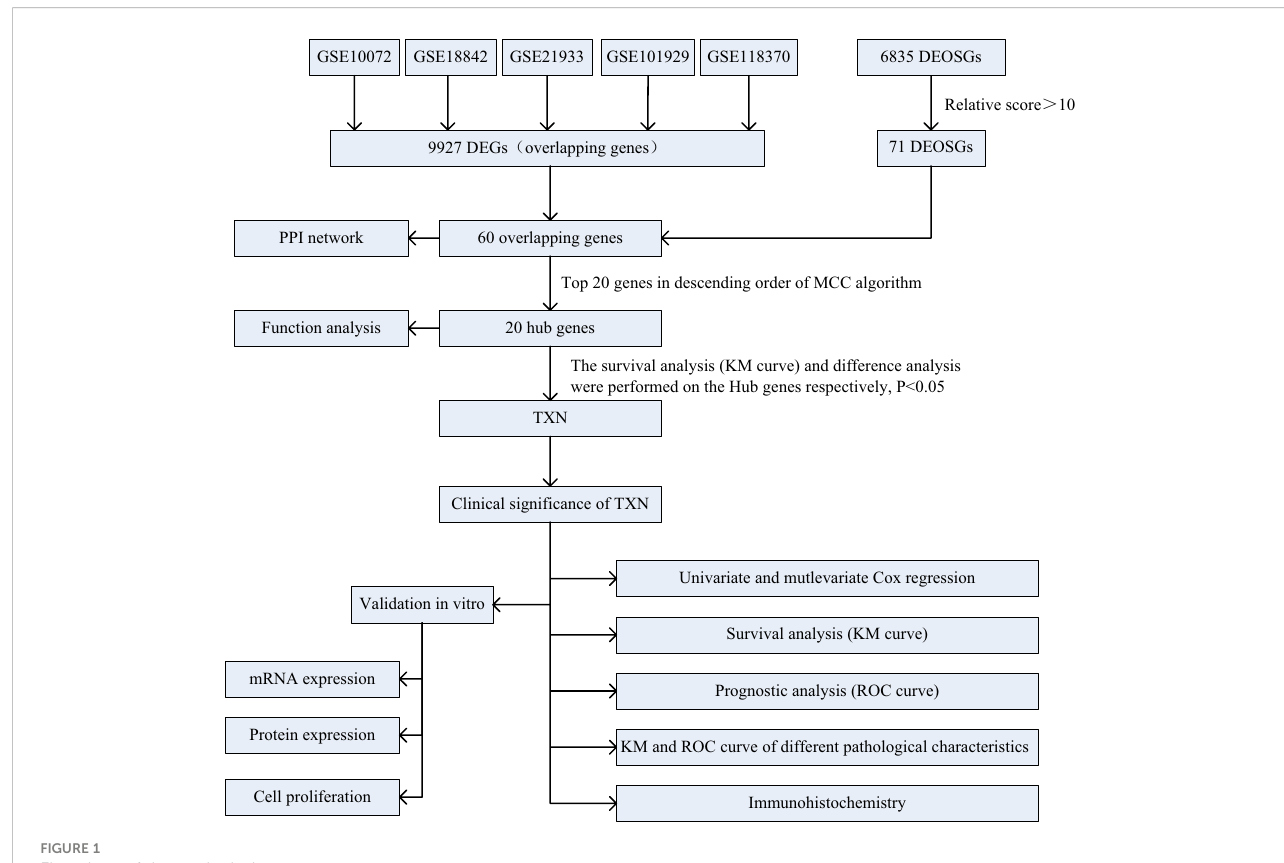
FIGURE 1 Flowchart of the study